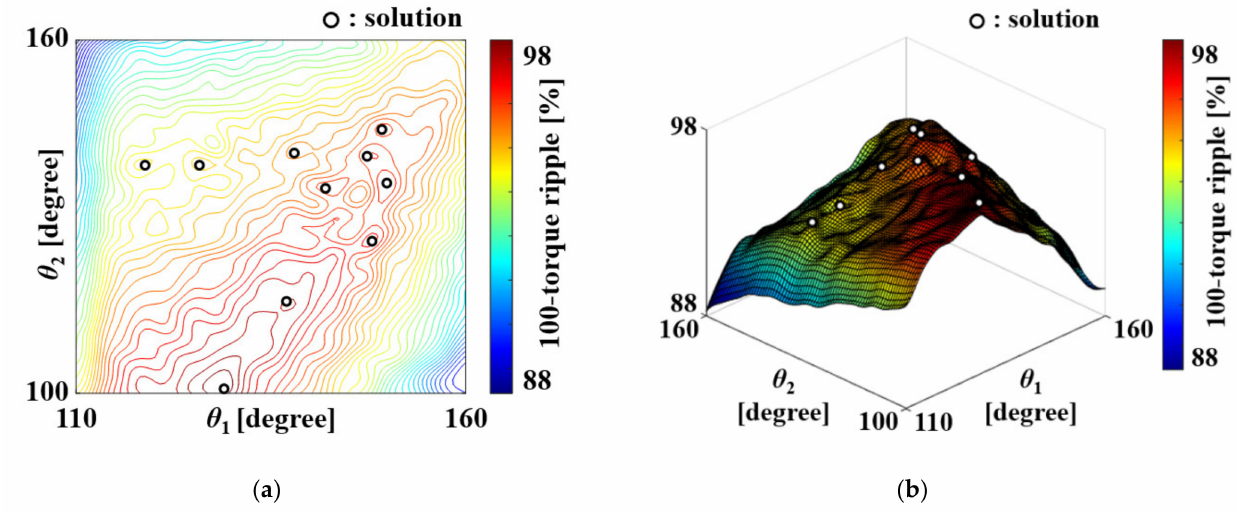
Figure 6. Surrogate model of torque ripple domain according to the magnet angle of IPMSM. ( a ) Contour plot; ( b ) Three-dimension